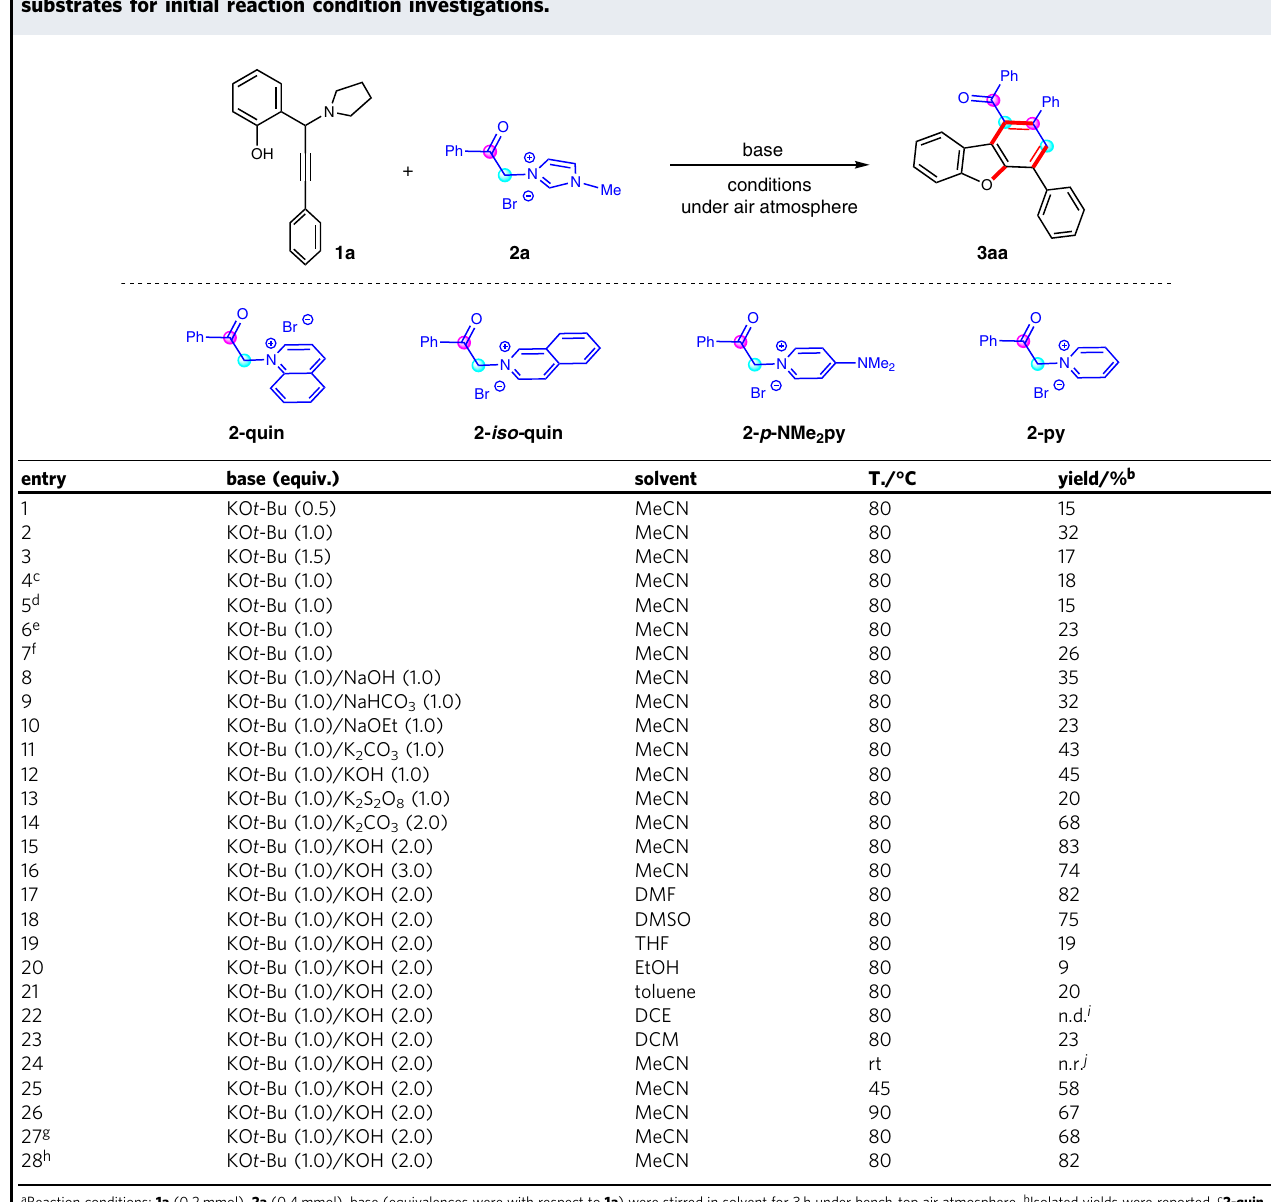
Table 1 Optimization of reaction conditions a . Propargylic amine 1a and imidazolium salt 2a were used as the prototypical substrates for initial reaction condition